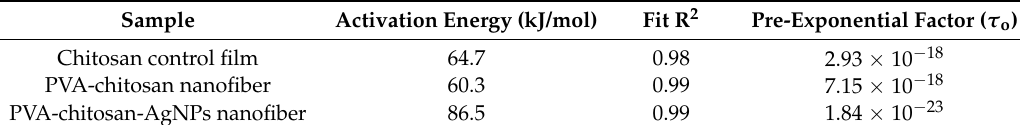
Table 2. Calculated activation energies for Process I relaxations of all samples.